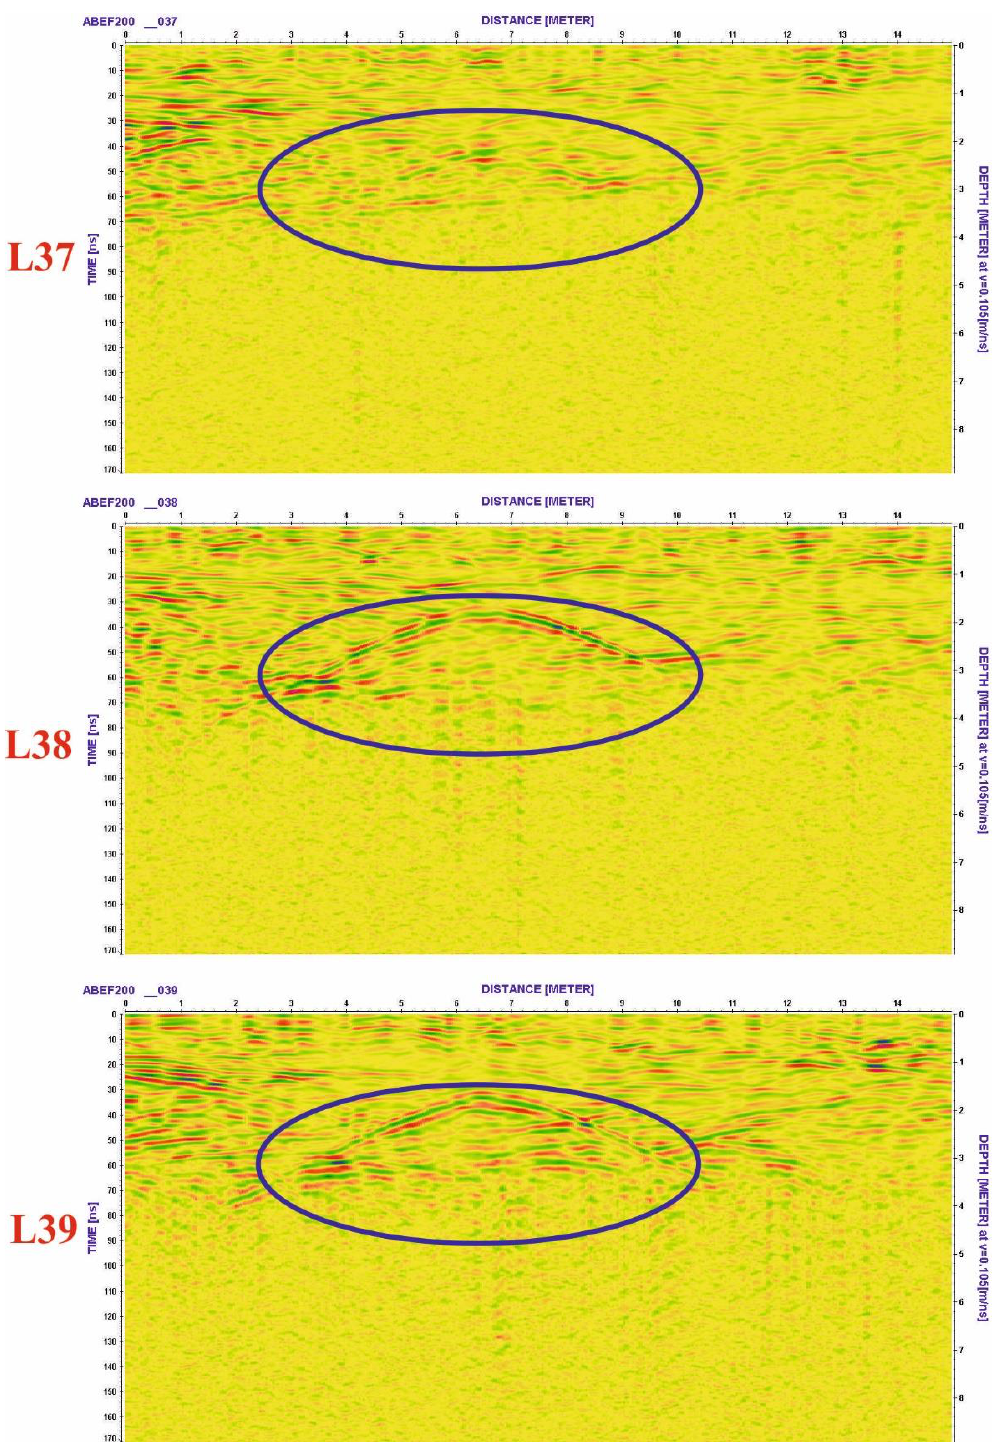
Figure 9. Radargram sections of three successive crossline profiles (L37, L38 and L39) executed on grid No. (3) during detailed survey in Abydos site. Their lengths are 15 m. These sections show the same hyperbolic shape indicated in the reconnaissance profiles with the same dimension, amplitude and depth. It was shown in the blue circle.